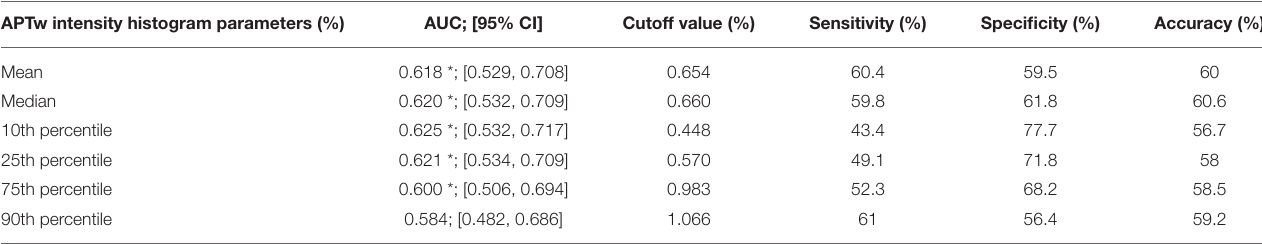
Significant AUC values are marked with a star ( *